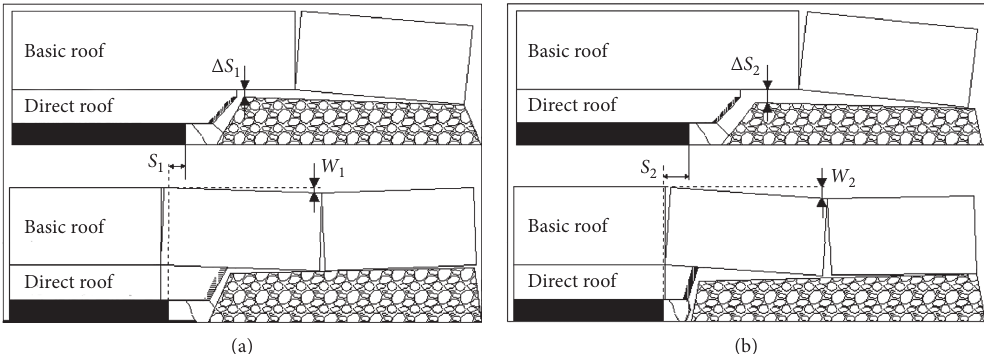
Figure 6: The rotation motion diagram of the basic top block under different propulsion speeds. (a) Slow advancing stage. (b) Fast advancing